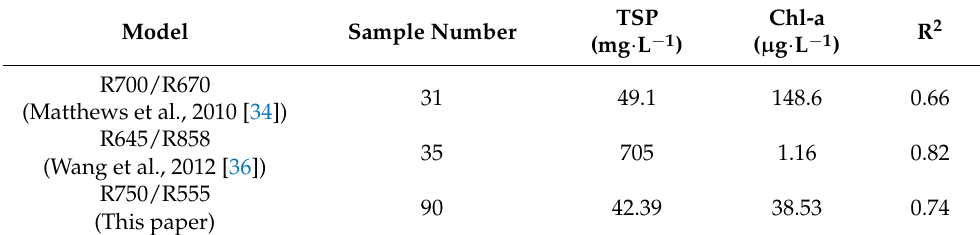
Table 10. Comparison of retrieval results for two-band TSP ratio